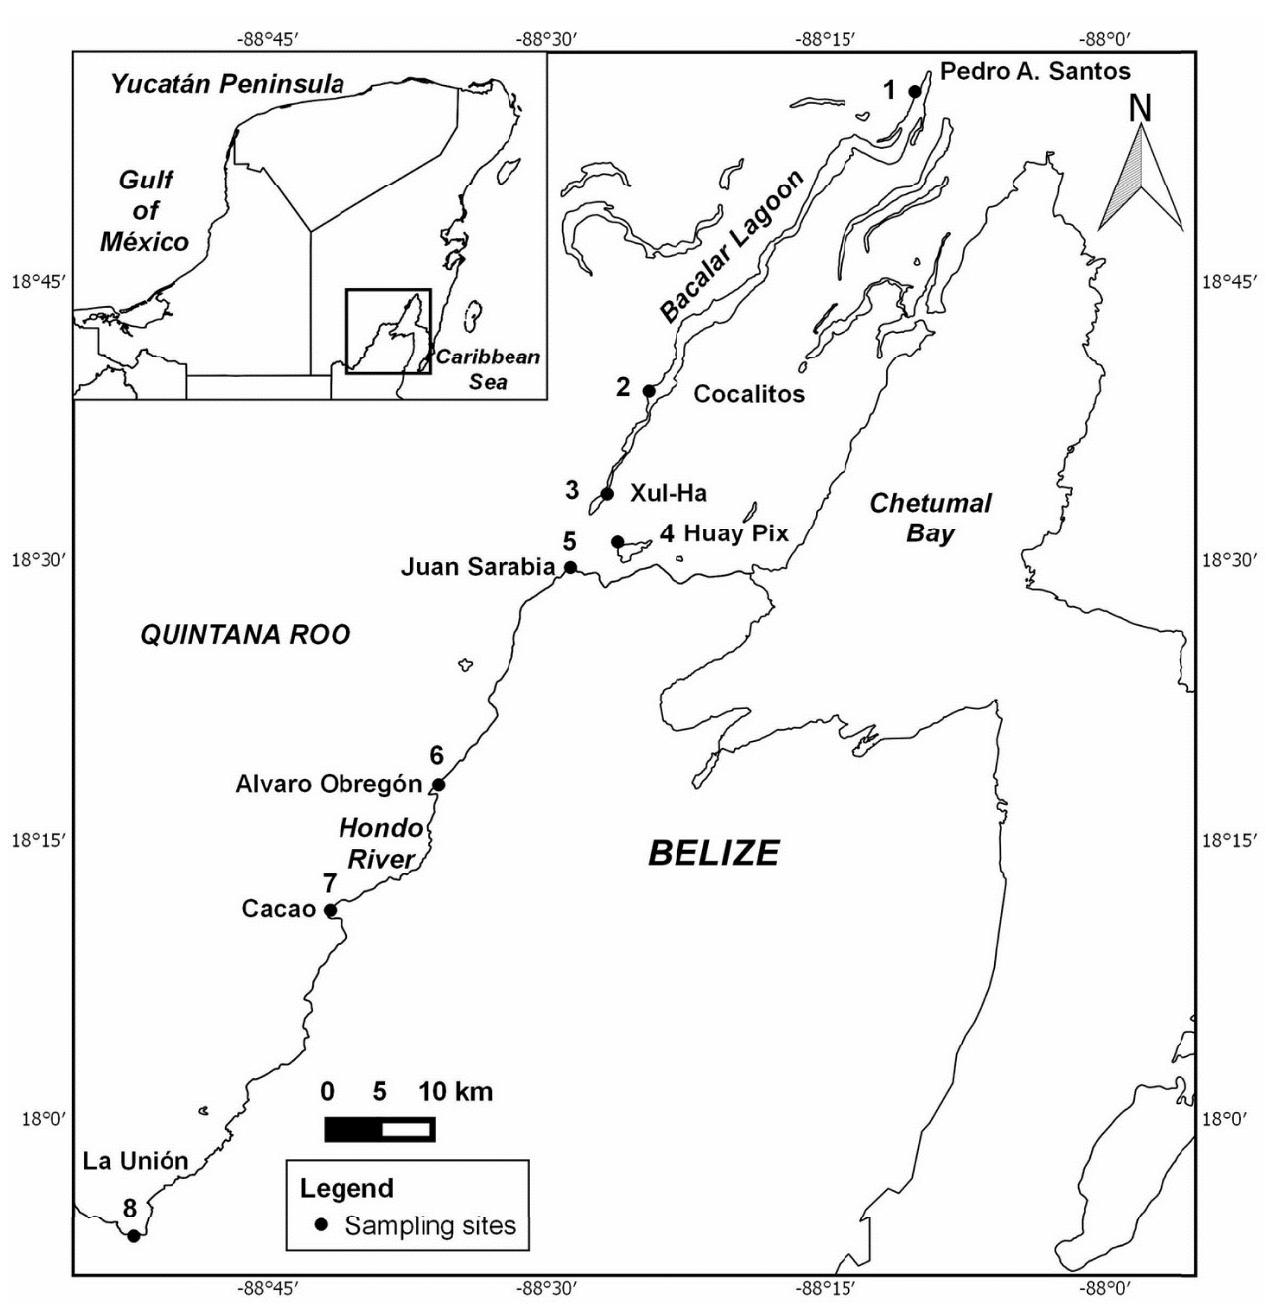
Fig 1. Sampling locations. The map was prepared using QGIS v 2.8.2 under the INEGI (Instituto Nacional de Geografı´a Estadı´stica e Informa´tica) free documentation license from topographic chart E16A66 (Scale 1:50,000) (www.inegi.org.mx/app/areasgeograficas/?ag=23).